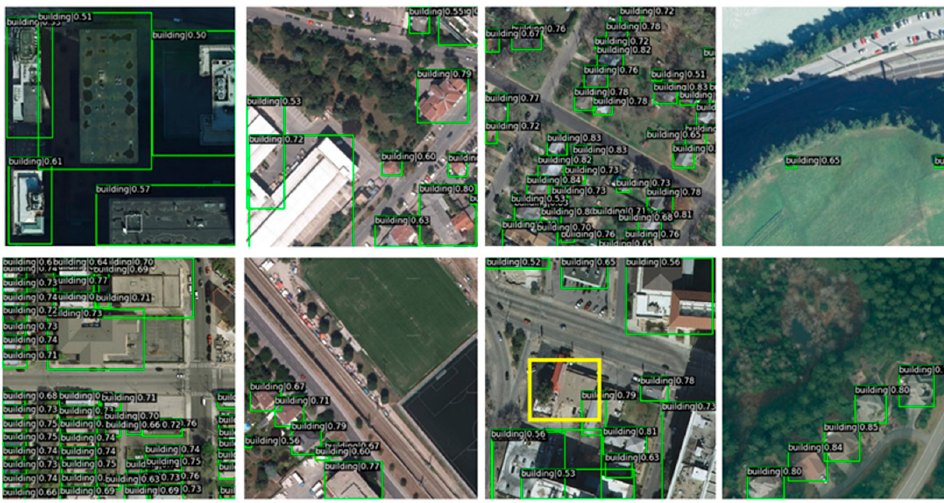
Figure 8. The AIBD dataset’s visualized test results using different algorithms.